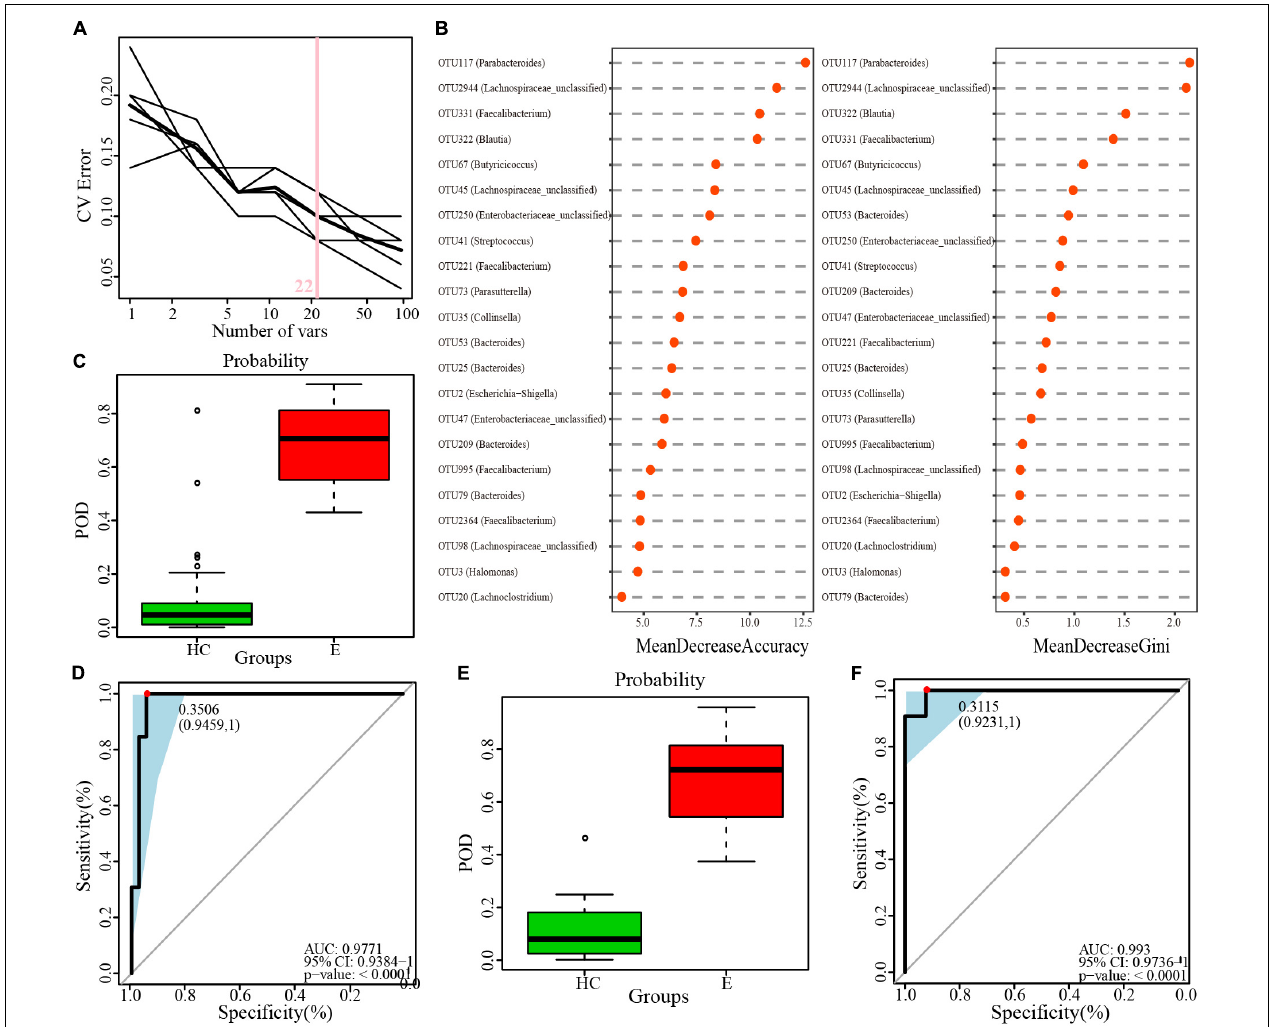
FIGURE 9 | Identification of microbial OTU-based Ep markers by random forest models. (A) 22 OTUs were selected by random forest models as the optimal epilepsy biomarkers. (B) Importance distribution map of the selected microbial markers in the model. (C) POD was significantly higher in Eps than HCs in the training set. (D) The POD index had an AUC = 0.9771 with a 95% CI = 0.9384–1 between Eps and HCs in the training set. (E) POD was significantly higher in Eps than HCs in the test set. (F) The POD index had an AUC = 0.993 with a 95% CI = 0.9736–1 between Eps and HCs in the test set. Eps, patients with epilepsy; HCs, healthy controls; OTUs, operational taxonomic units; CV error, cross-validation error; POD, probability of disease; AUC, area under the